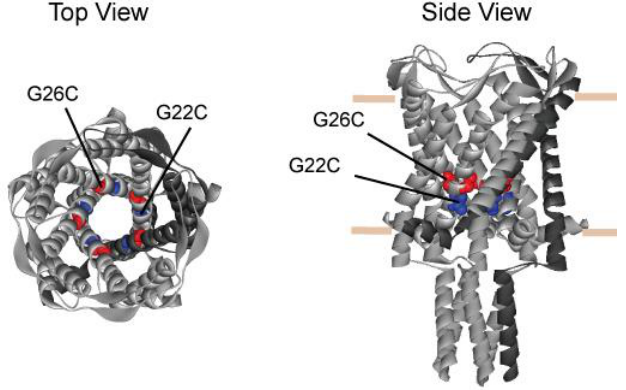
Figure 1. Schematic representation of MscL derived from the crystal structure of M. tuberculosis . The figure shows the structure of TB MscL from top ( left ) and side ( right ) views. The position of residues A20 and G24 (G22C and G26C in E. coli MscL, respectively) are shown as CPK in the pentameric structure. The predicted position of the lipid leaflet is indicated by horizontal bars in the side view. Note that G26 is higher in the vestibule, while G22 is more